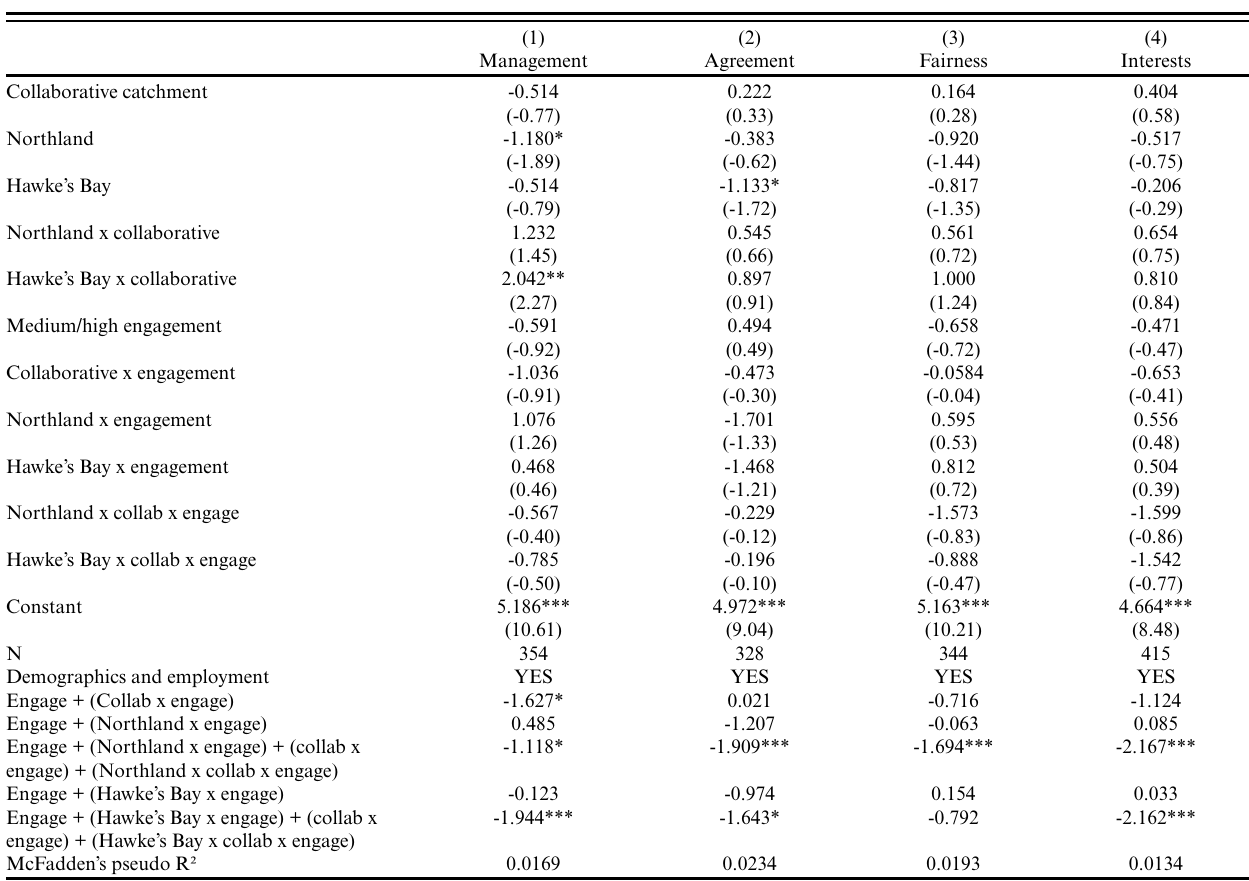
Table 6 . Marginal effects of engagement in freshwater issues on perceptions of management, agreement, the extent to which interests and concerns are taken into account, and